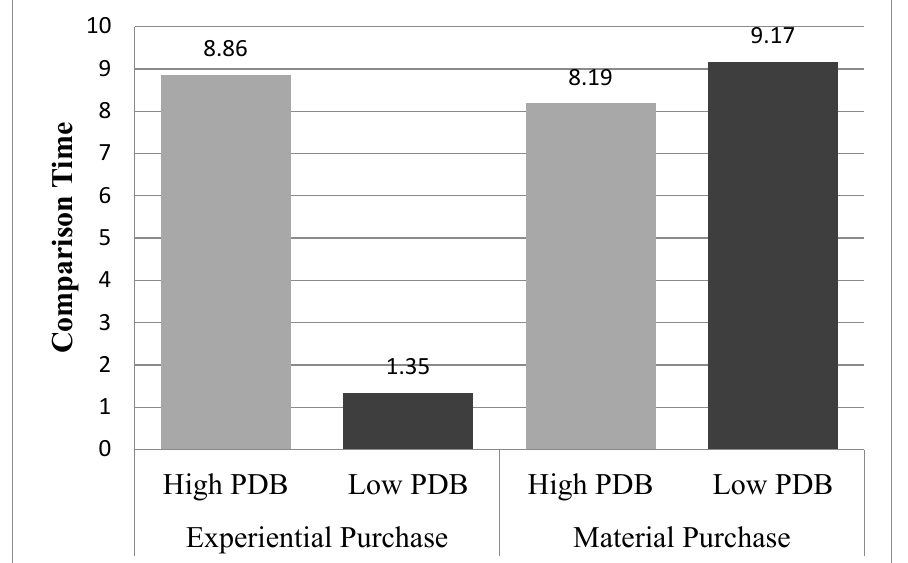
Figure 3. Results of study 2.